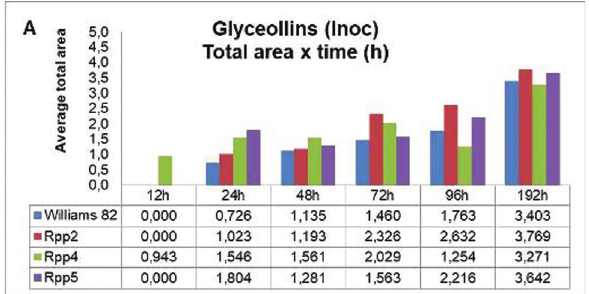
Figure 3 - Glyceollin concentrations in soybean leaves of different geno- types [Williams 82, PI 230970 (Rpp2), PI 459025 (Rpp4), PI 200487 (Rpp5)] inoculated with Phakopsora pachyrhizi , evaluated at six time pe- riods (12, 24, 38, 72, 96, and 192 hai). Data represent the mean of three replicates of representative inoculated